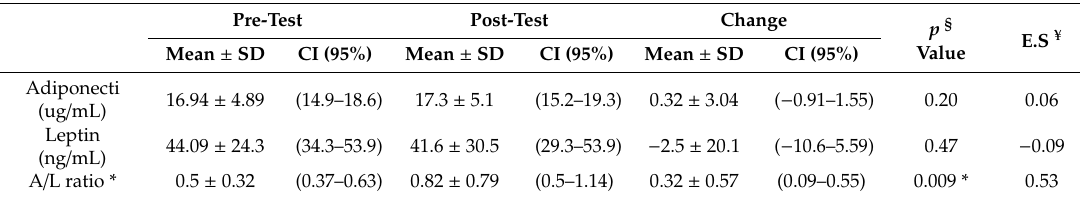
Table 2. Intragroup comparisons. Whole sample (n = 26).